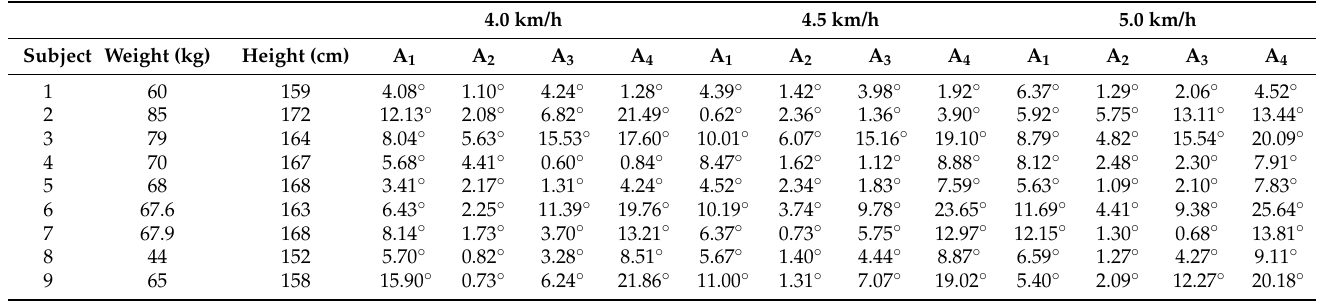
Table A1. MAE of each one of the four differences at different speeds in all subjects.